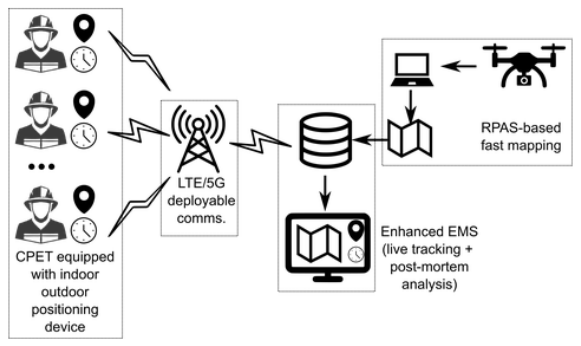
Figure 1. IOPES project